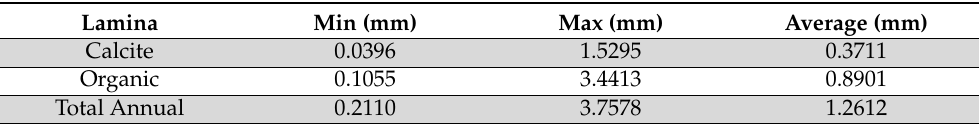
Table 2. Subset of varve thickness data showing the maximum, minimum and mean varve thickness of the individual calcite, organic and combined laminae. Lamina Min (mm) Max (mm) Average (mm) Calcite 0.0396 1.5295 0.3711 Organic 0.1055 3.4413 0.8901 Total